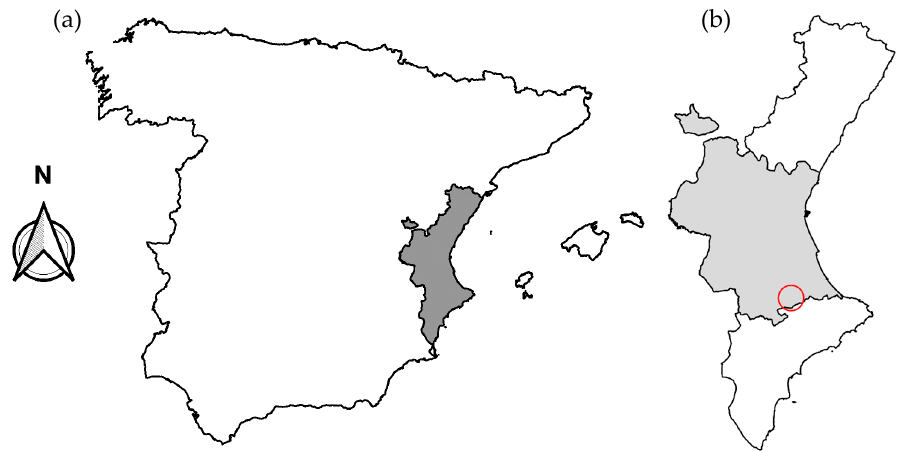
Figure 1. Location of the Valencian Community in Spain ( a ) and location of the studied irrigation community at the southern limit of the Valencia province ( b ).